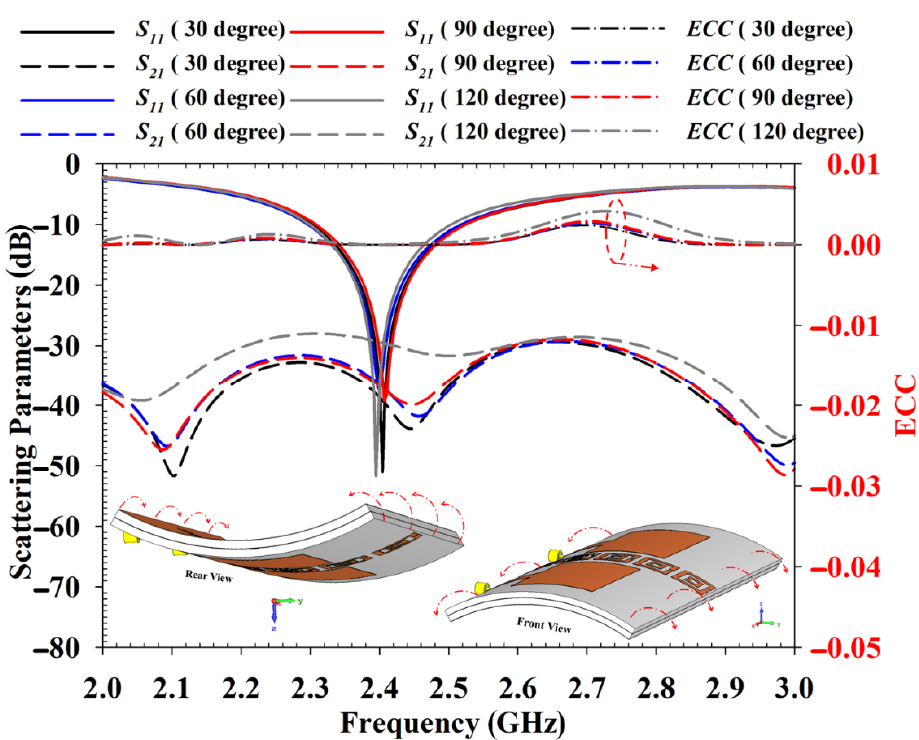
Figure 17. Bending analysis of the antenna at y -axis.